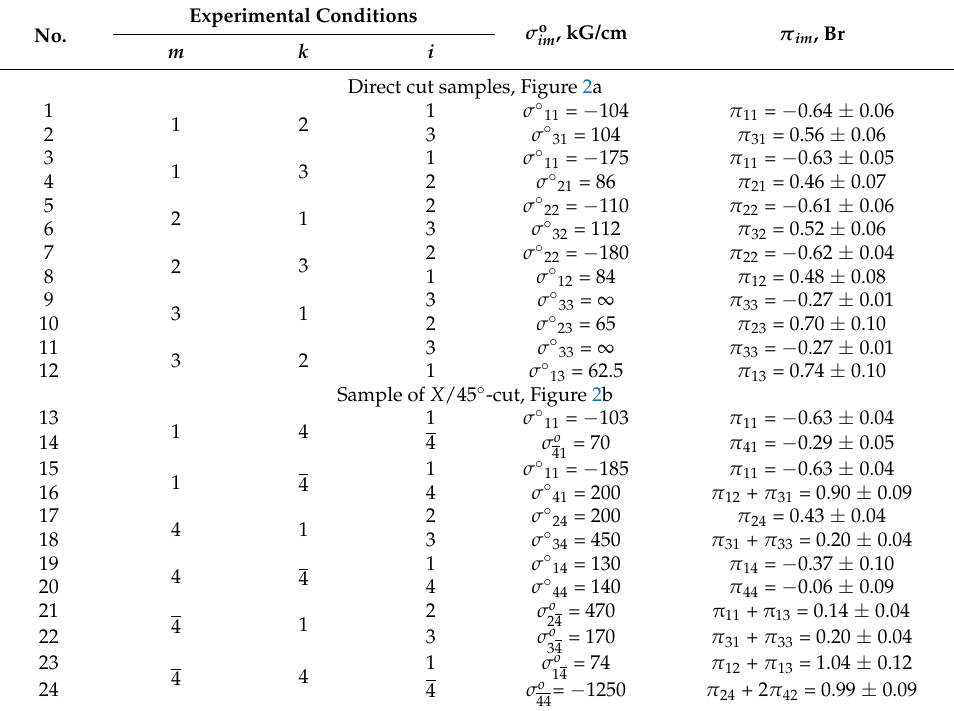
Table 3. Results of investigations of POE in LiTaO 3 crystals ( λ = 632.8 nm, T = 20 ◦ C, 1 Br = 1 Brewster = 10 − 12 m 2